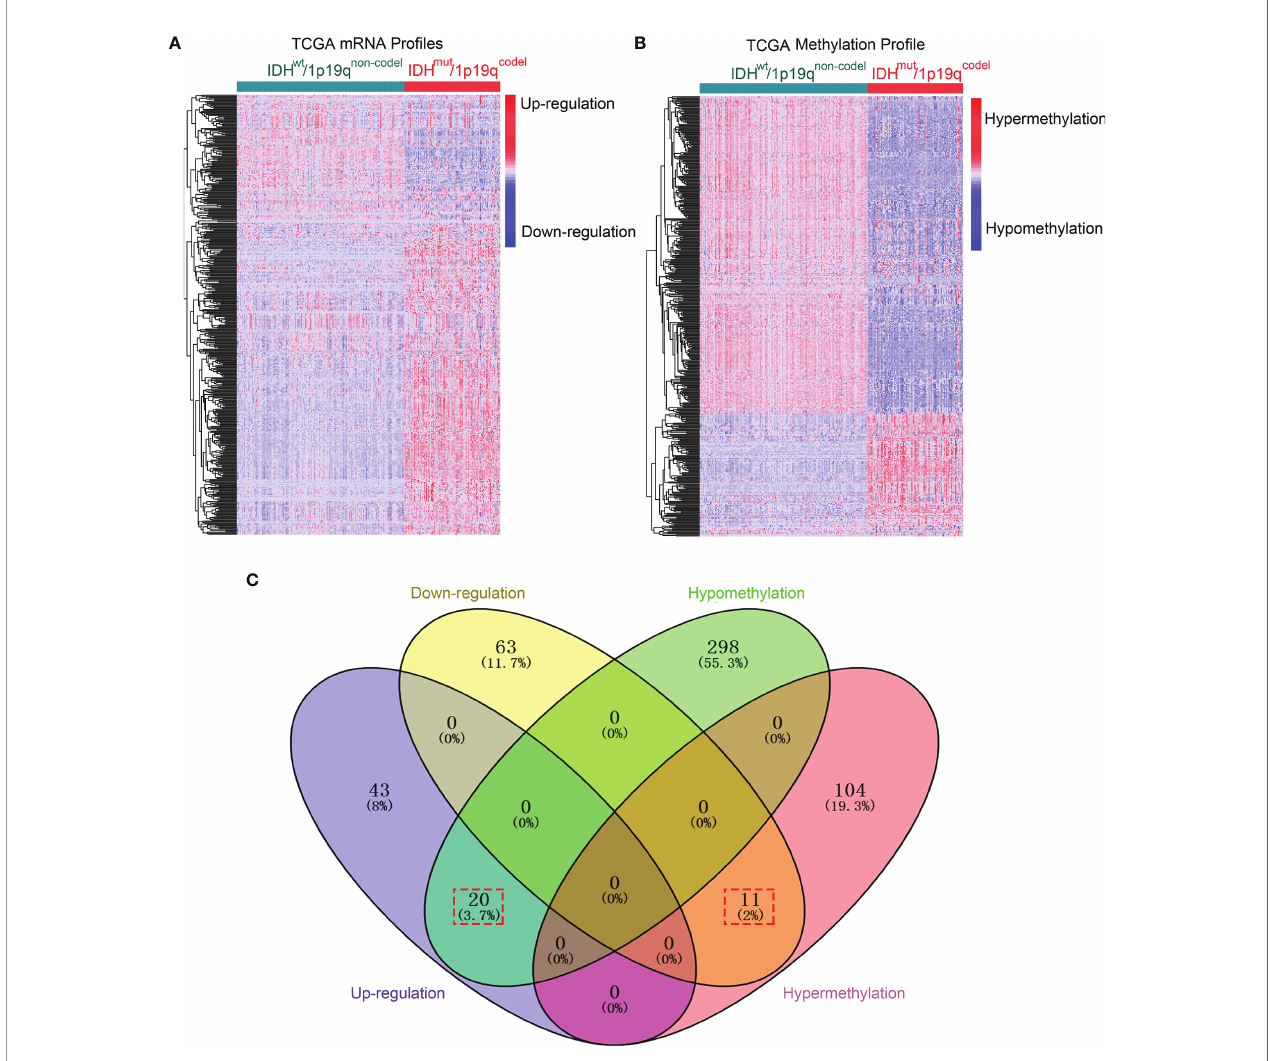
FIGURE 2 | DME genes were screened in IDH/1p19q subtypes in TCGA dataset. (A) The hierarchical bi-clustering analysis with TCGA dataset indicated signi fi cant DEGs with 74 downregulated and 63 upregulated genes in LGGs classi fi ed by IDH and 1p/19q status. (B) The hierarchical bi-clustering analysis with TCGA dataset indicated signi fi cant DMDGs with 318 hypomethylated and 115 hypermethylated genes in LGGs classi fi ed by IDH and 1p/19q status. (C) The Venn diagram showed 31 DME genes with 20 hypomethylation that paralleled upregulation and 11 hypermethylation that paralleled downregulation. DEGs were analyzed by the limma package. DMDGs were analyzed by the MethyMix